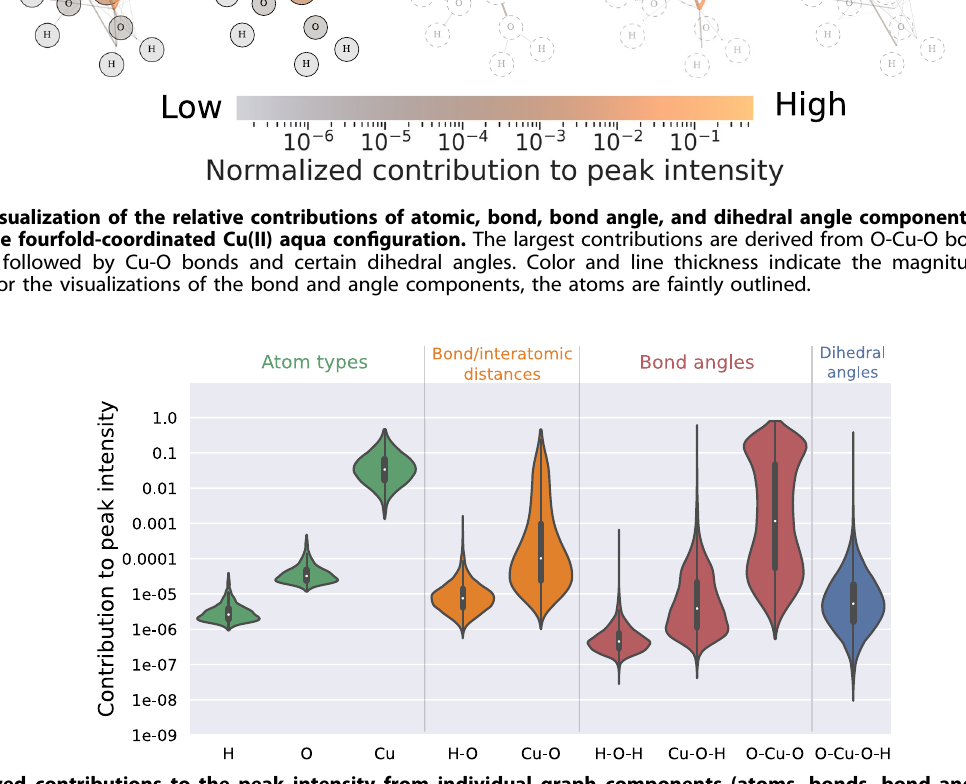
Fig. 7 Normalized contributions to the peak intensity from individual graph components (atoms, bonds, bond angles, and dihedral angles). These contributions were obtained from the interpretable variant of